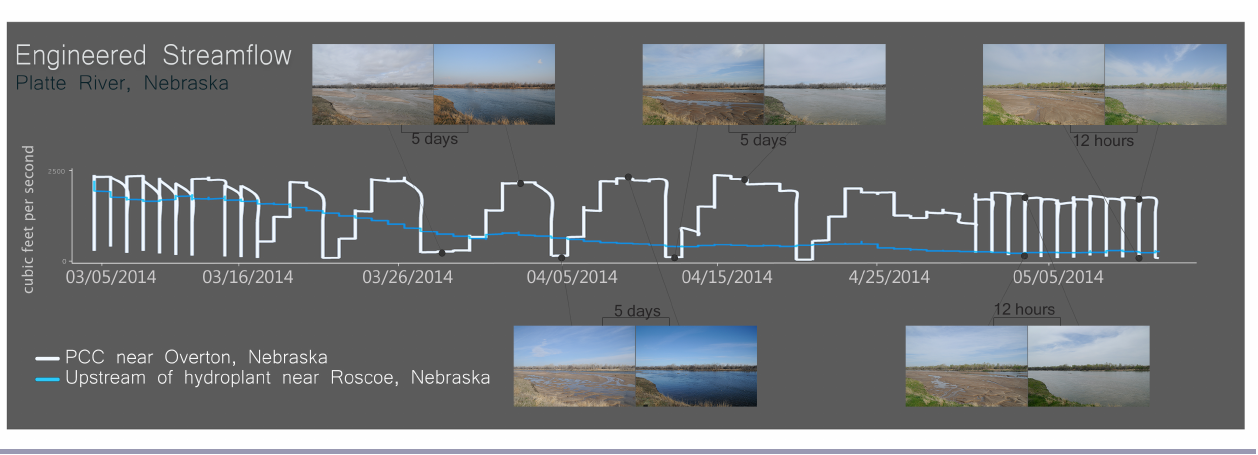
Fig. 6 . Static time-lapse data sequence illustrating the hydrograph during the spring of 2014 at Plum Creek Complex (light blue), a site located downstream from a hydropower plant on the Platte River in Nebraska. The hydrograph of a site located upstream, without controlled water releases, is included for comparison (dark